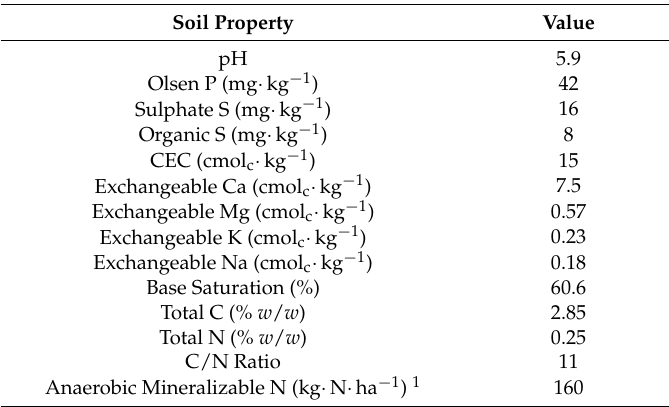
Table 2. Initial soil fertility status of trial